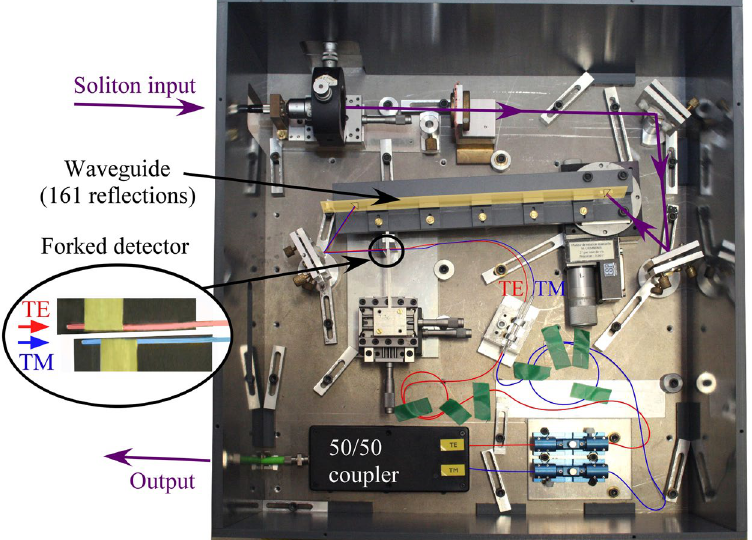
Figure 2. Experimental setup for the soliton experiment. Photograph of the telecommunication system for λ = 1550 nm including the plane waveguide. The swivelling detection is performed here by the forked detector. The red and the blue fibres carry the TE and the TM beams